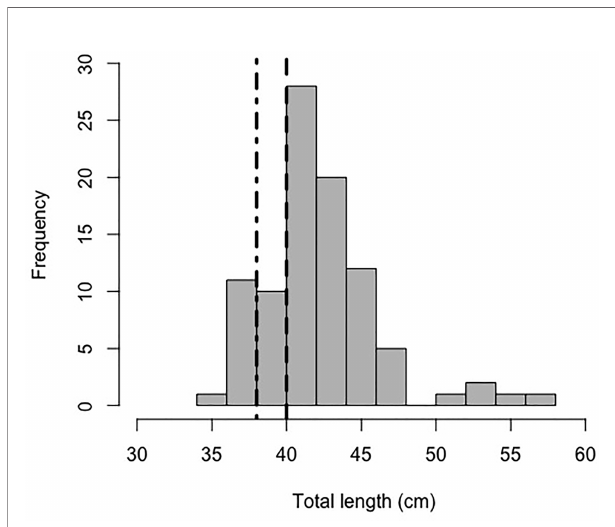
FIGURE 3 | Histogram of petrale sole total length (cm) measured in 2018 at eastern Santa Lucia Bank. The thick dot dashed line at 38 cm is the length at which all male petrale sole are likely mature (Harry, 1959) and the dotted line at 40 cm is the length at which all females are likely mature (Hannah et al.,